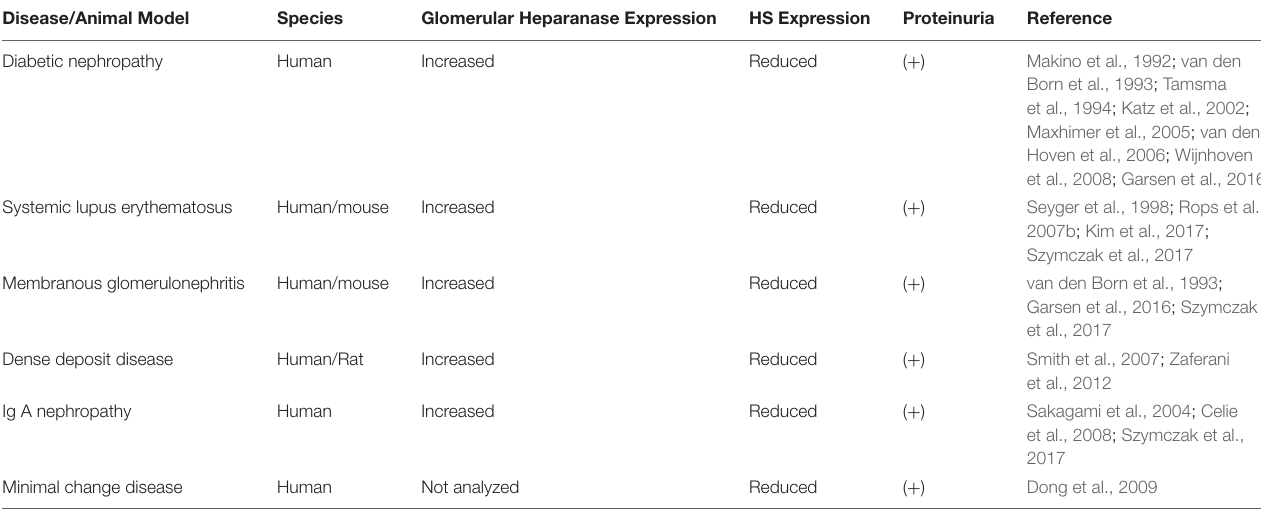
TABLE 1 | Involvement of HS and heparanase expression in proteinuric diseases. Disease/Animal